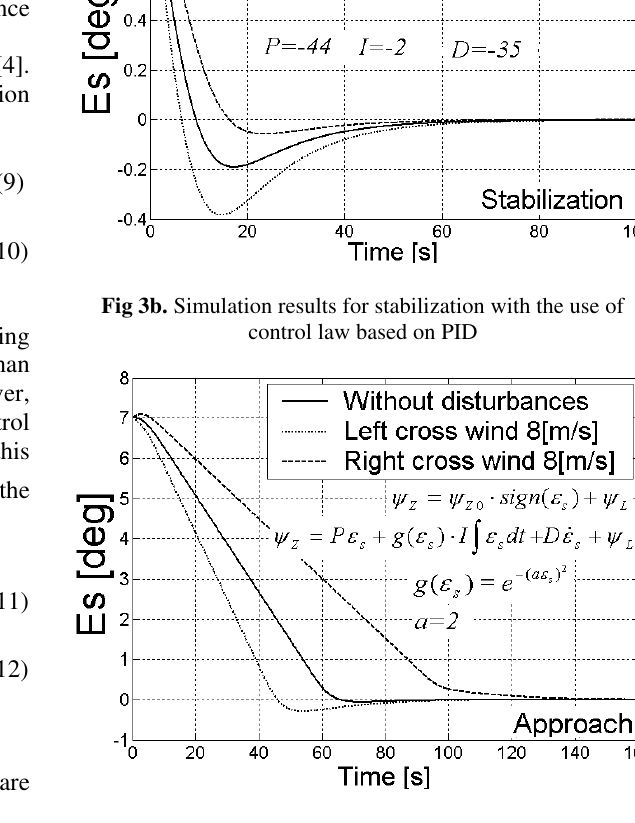
Fig 3c. Simulation results for whole approach with the use of control laws (9) and